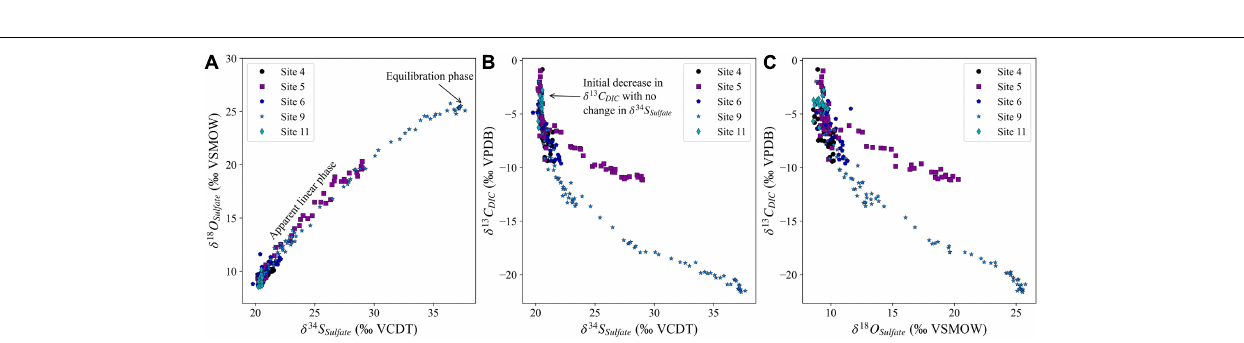
FIGURE 3 | The increase in the sulfur (A) and oxygen (B) isotopic composition of sulfate as a function of the decrease in pore fluid sulfate concentrations.